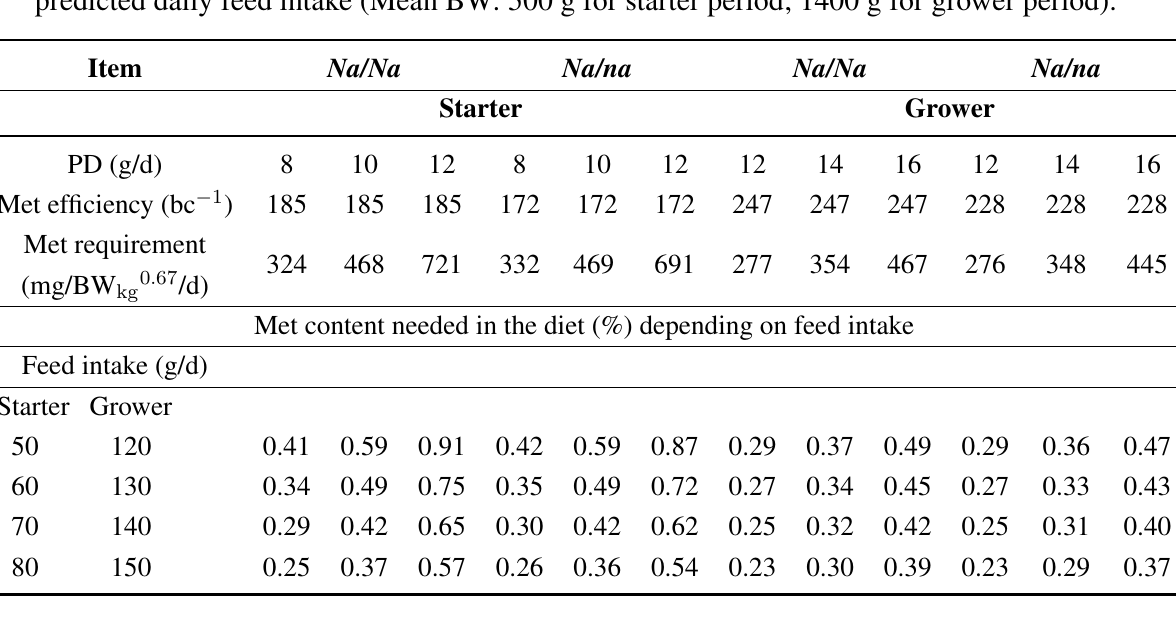
Table 5. Modeling of Met requirement data for female naked neck ( Na/Na ; Na/na ) meat type chicken in starter and grower periods, depending on daily body protein deposition (PD)